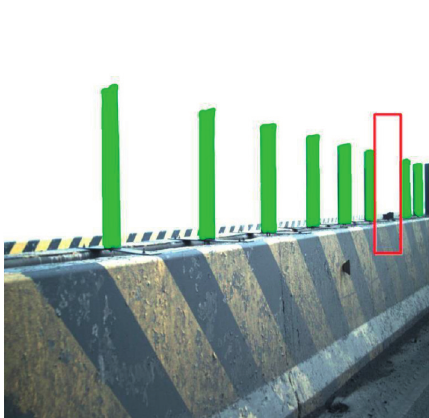
Figure 8: The location of the missing anti-glare panel is based on distance consistency.